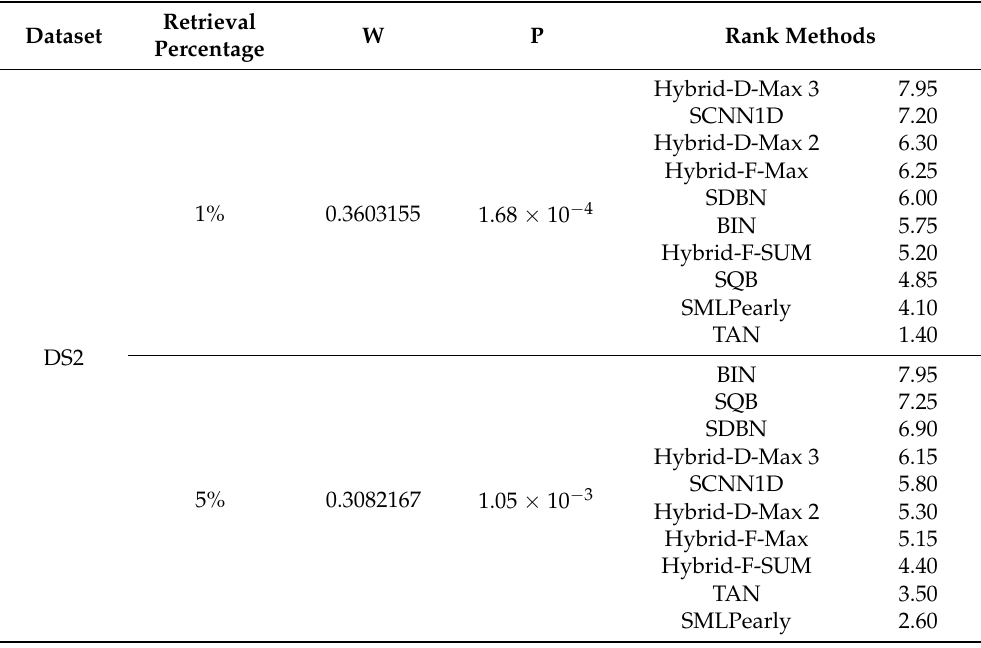
Table 14. Ranking of hybrid Siamese similarity models based on (TAN, BIN, SQB, SDBN, SCNN1D, and SMLP) using Kendall W test results for DS2, at top 1% and 5%.